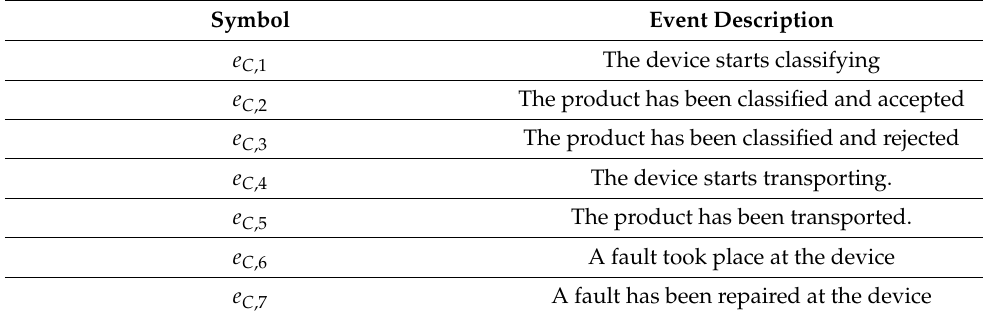
Table 3. States of the classifier and transportation device. Table 4. Events of the classifier and transportation